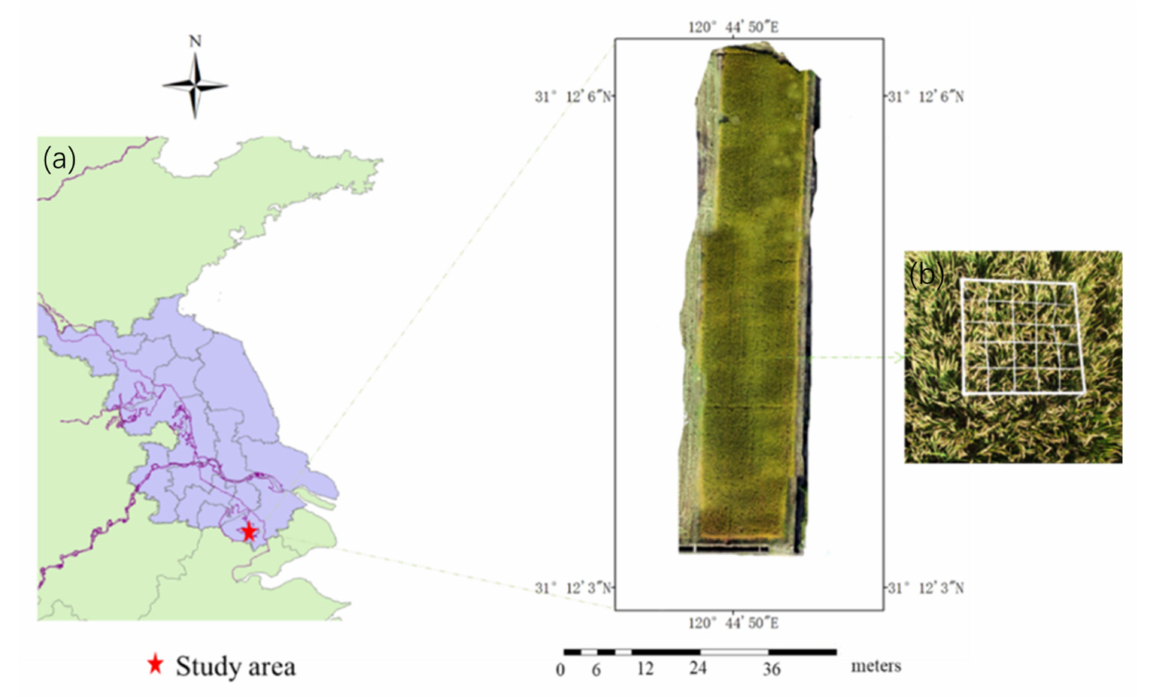
Figure 1. Rice density experiment at Jiangsu Wujiang Modern Agricultural Industrial Park, 2020. ( a ) Study area. ( b ) Sampling frame.